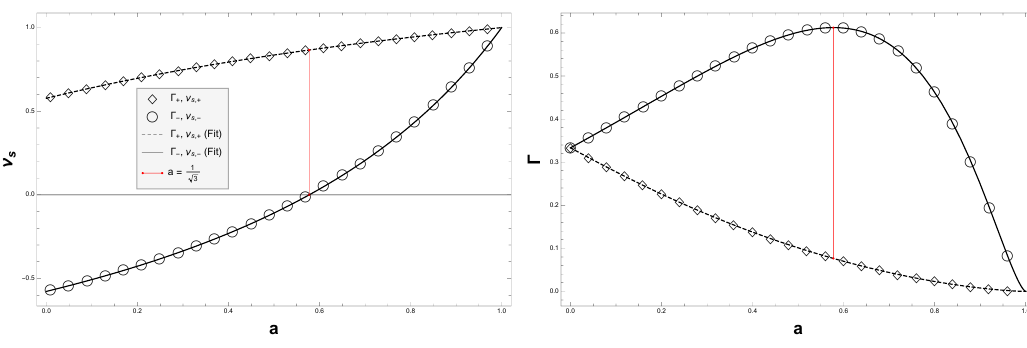
Figure 8 . Sound propagation in a simply spinning black hole. Speed of sound, v s , and sound attenuation, (cid:0), shown as a function of the angular momentum parameter a of the rotating black hole. There are two speeds of sound, v s; (cid:6) , and attenuations, (cid:0) (cid:6) , which are de(cid:12)ned through the small j expansion (cid:23) ( j ) = v s; (cid:6) ( a ) j (cid:0) (cid:0) (cid:6) ( a ) j 2 + O ( j 3 ). The (cid:12)ts found show that v s; (cid:6) ; (cid:12)t = ( 1 (cid:0) a 2 ) 3 = 2 with (cid:31) 2 (cid:25) 10 (cid:0) 100 and (cid:0) s; (cid:6) ; (cid:12)t = 1 (cid:16) a 3